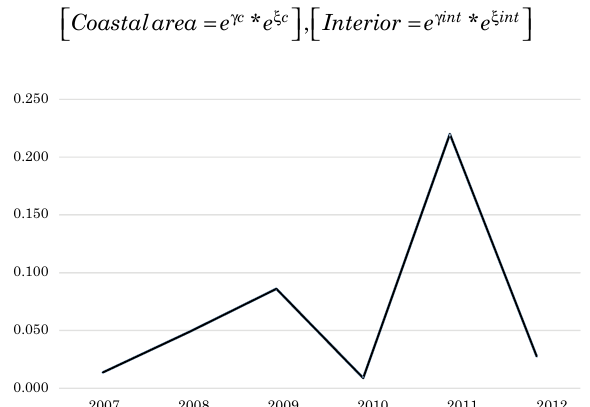
Fig. 4. Constant price relationship and convergence